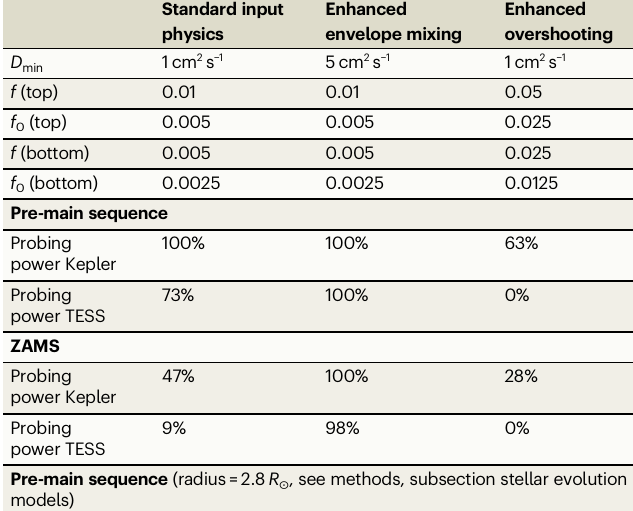
Table 1 | Overview of the different parameters for the stellar evolution calculations used in this work and summary of potentially detectable frequency differences